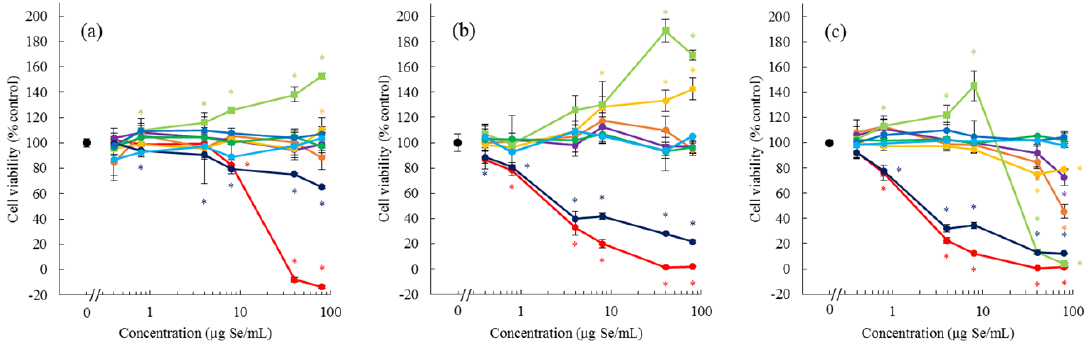
Figure 2. Effect of bioselenocompounds on Caco-2 and HepG2 cell viability. Caco-2 cells were exposed to selenite, selenate, SeCN − , SeMet, MeSeCys, SeHLan, SeCys 2 , SeSug1, or TMSe + for 6 h ( a ). HepG2 cells were exposed to each bioselenocompound for 24 h ( b ) and 48 h ( c ). Points and bars are means ± SD for 3 wells. Statistical analysis included the one-way analysis of variance followed by the Student’s t -test. The level of significance was set at p < 0.05, and is indicated by an asterisk (*).